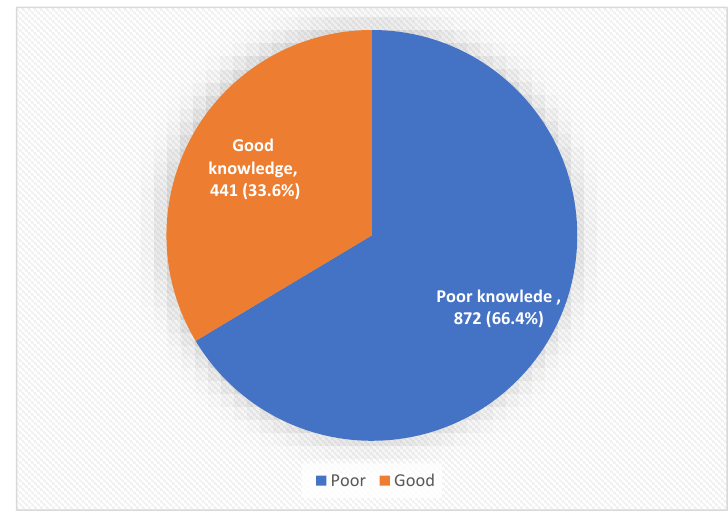
Figure 1. Overall public knowledge level regarding cancer and cancer screening, Saudi Arabia.